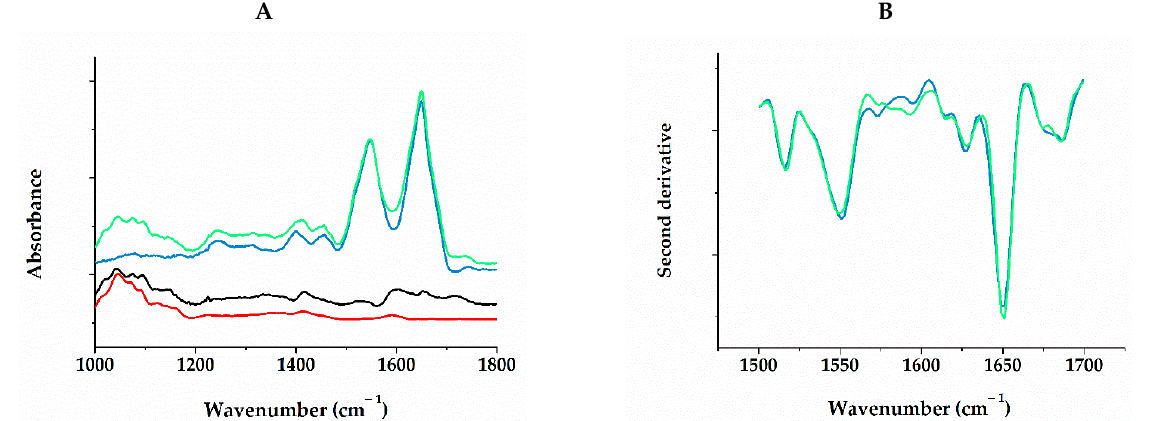
Figure 5. FTIR spectra of Fb adsorbed on the surface of ZnSe crystal (blue), Fb with RG adsorbed on top of it (green), difference between them (black) and RG spectrum (red) ( A ); and second derivatives of absorption spectra of Fb (blue) and Fb/RG complexes (green) in the region of peptide groups absorption ( B ).